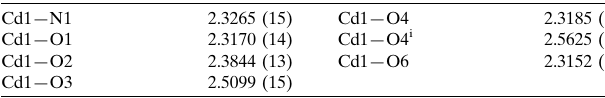
Selected bond lengths (A˚ ).